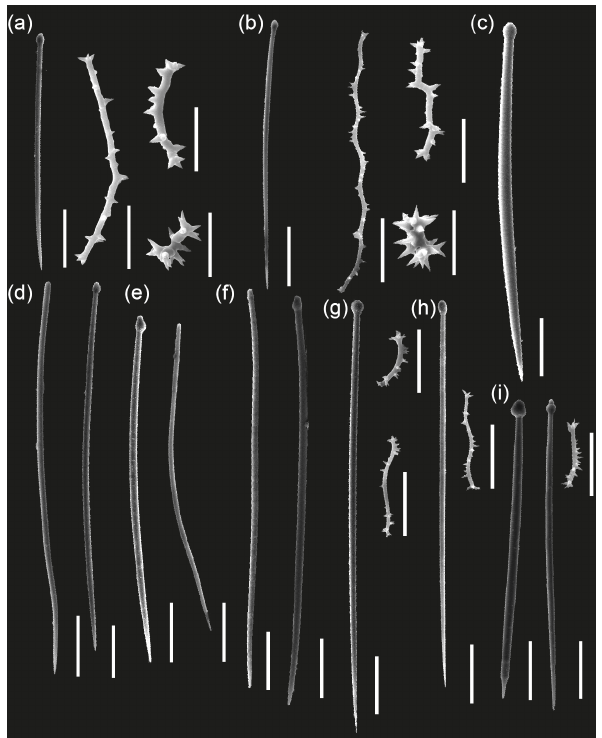
Figure 6. Spicules of boring sponges extracted from sponge tissue preserved in cavity networks in the scanned blocks. (a–b) Tylostyles and spirasters of Cliona schmidtii , (c) tylostyles of C. cf. celata 1, (d–f) tylostyles of C. cf. celata 2, (g–h) tylostyles and spirasters of C. cf. viridis , and (i) tylostyles and spirasters of C. rhodensis (Fig. 5A2) (scales: tylostyles = 50µm, spirasters =